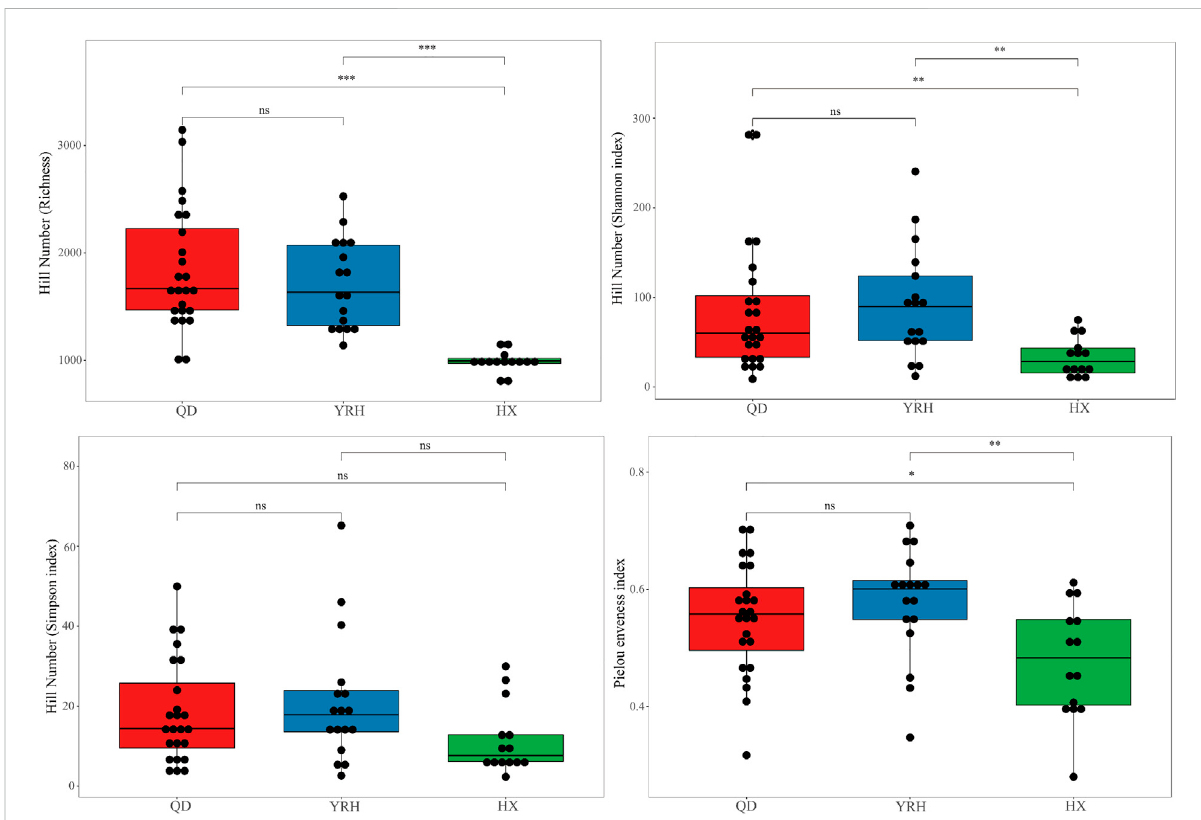
FIGURE 2 Boxplots showing the comparisons of alpha-diversity indices based on Hill numbers in the three regions. *, **, and *** represent the signi fi cant level of p < 0.05, p < 0.01, and p < 0.001 using Maun-Whitney U test., respectively. The ns indicates no signi fi cant difference in two regions.